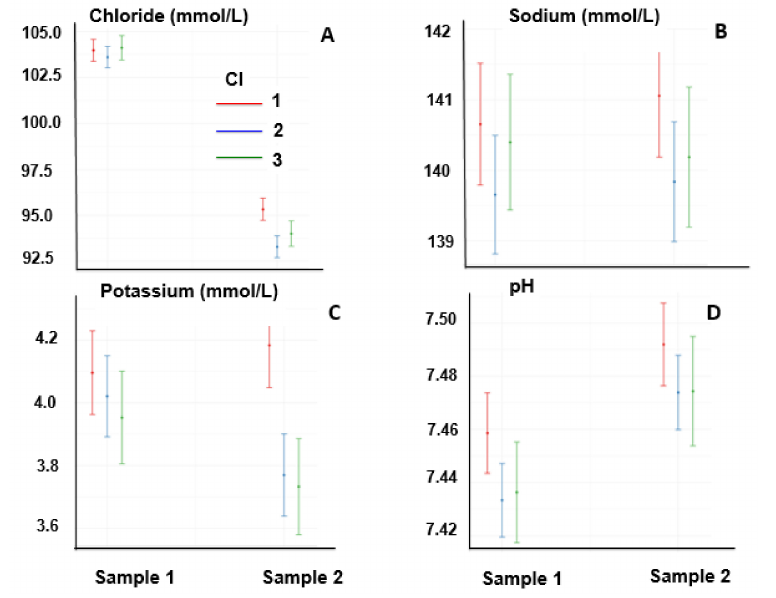
Figure 2. Chloride ( A ), sodium ( B ), and potassium ( C ) concentrations, and pH ( D ) of horses one day before the race (Sample 1) and at the end of the race (Sample